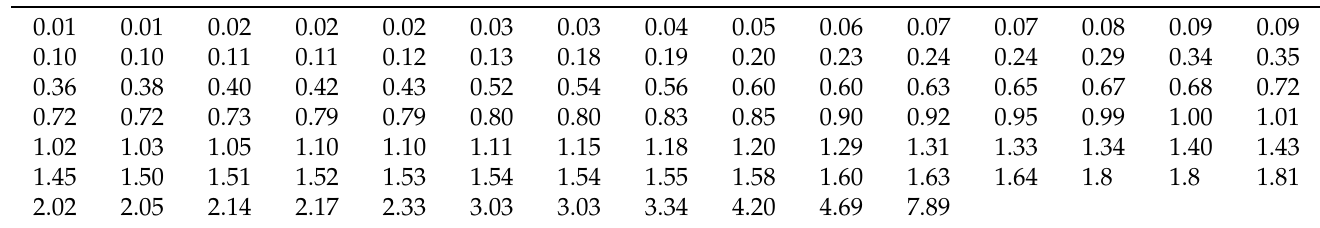
Table 13. Failure time data of Stress-Rupture Life of Kevlar 49/Epoxy Strands with pressure at 90% Data.